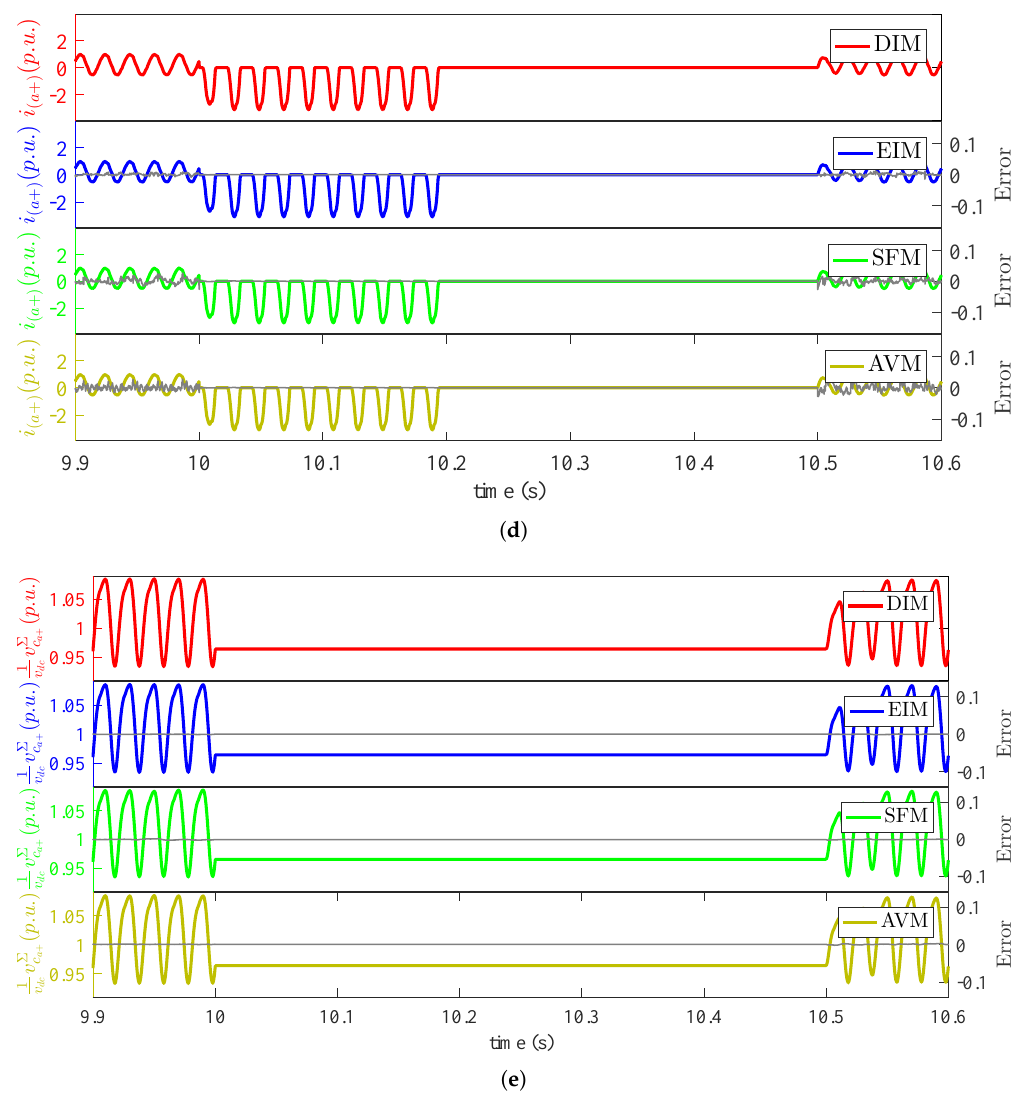
Figure 13. Pole to ground DC fault. ( a ) AC voltage v ac model error; ( c ) DC current i dc andthemodelerror; ( d ) positive arm current i ( a +) and the model error; ( e ) cumulative capacitor voltage v